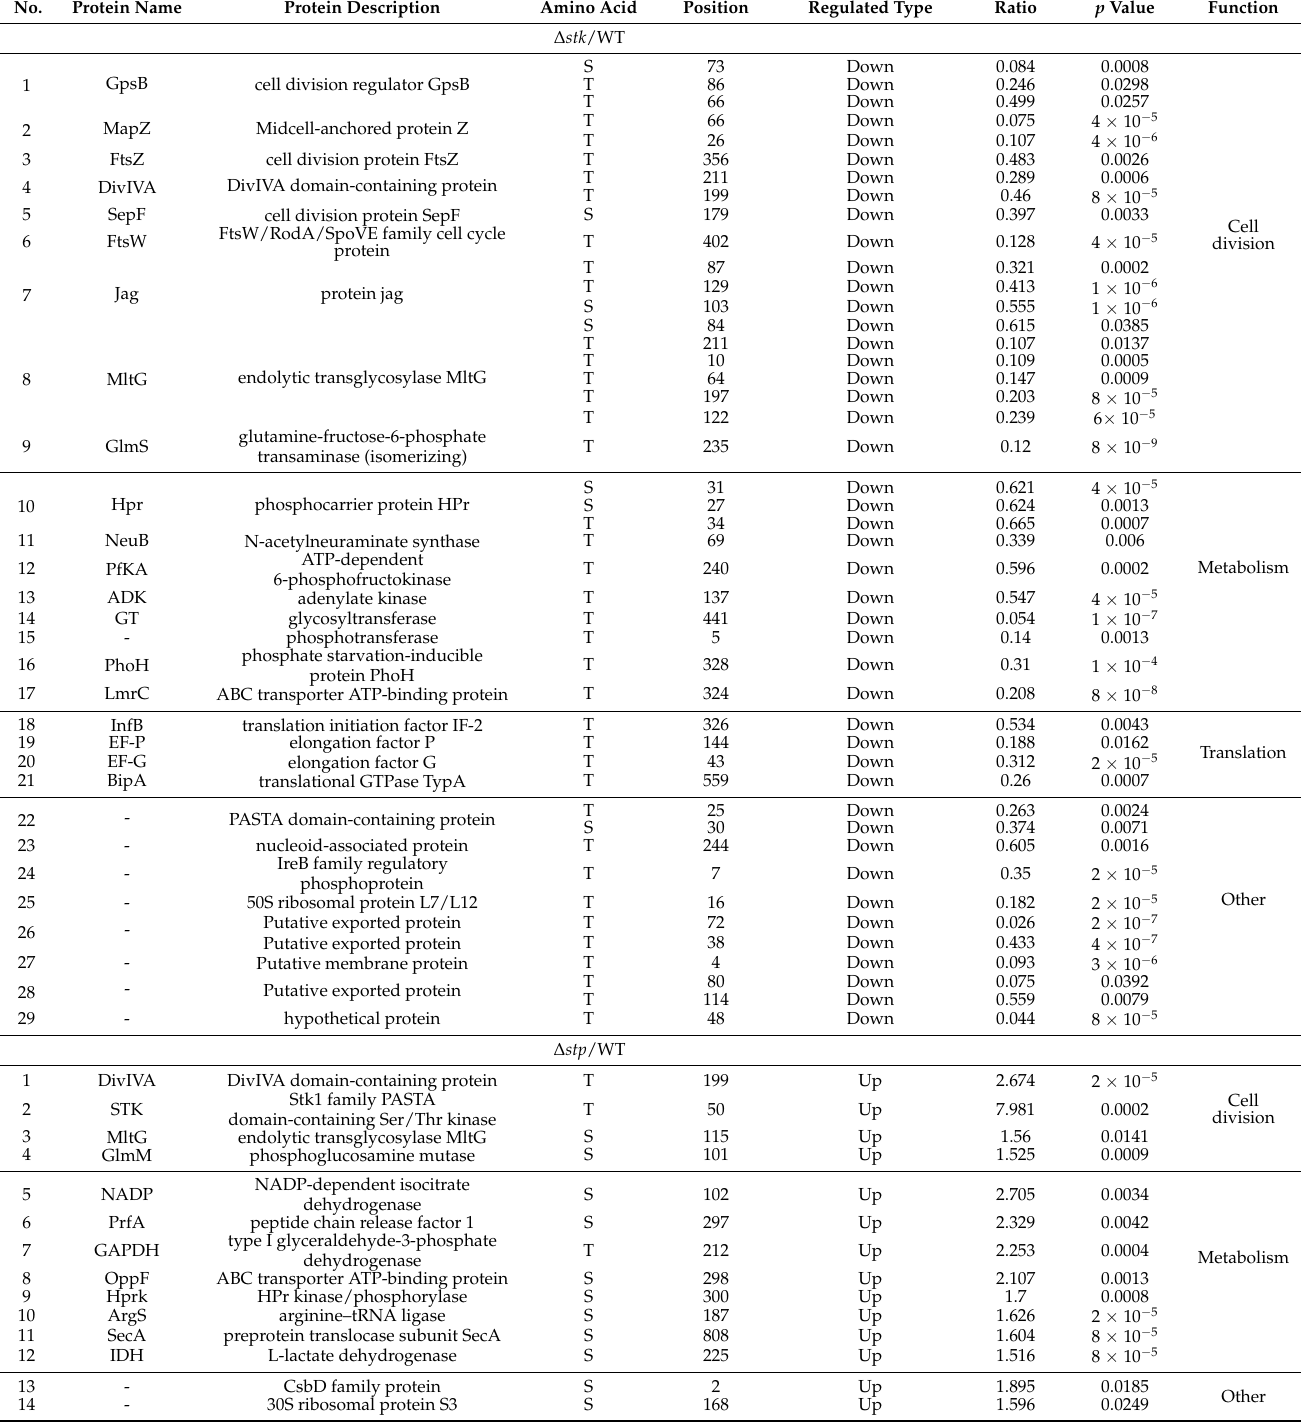
Table 2. Proteins with down- and up-regulated abundance after phospho-peptide enrichment in ∆ stk and ∆ stp compared with